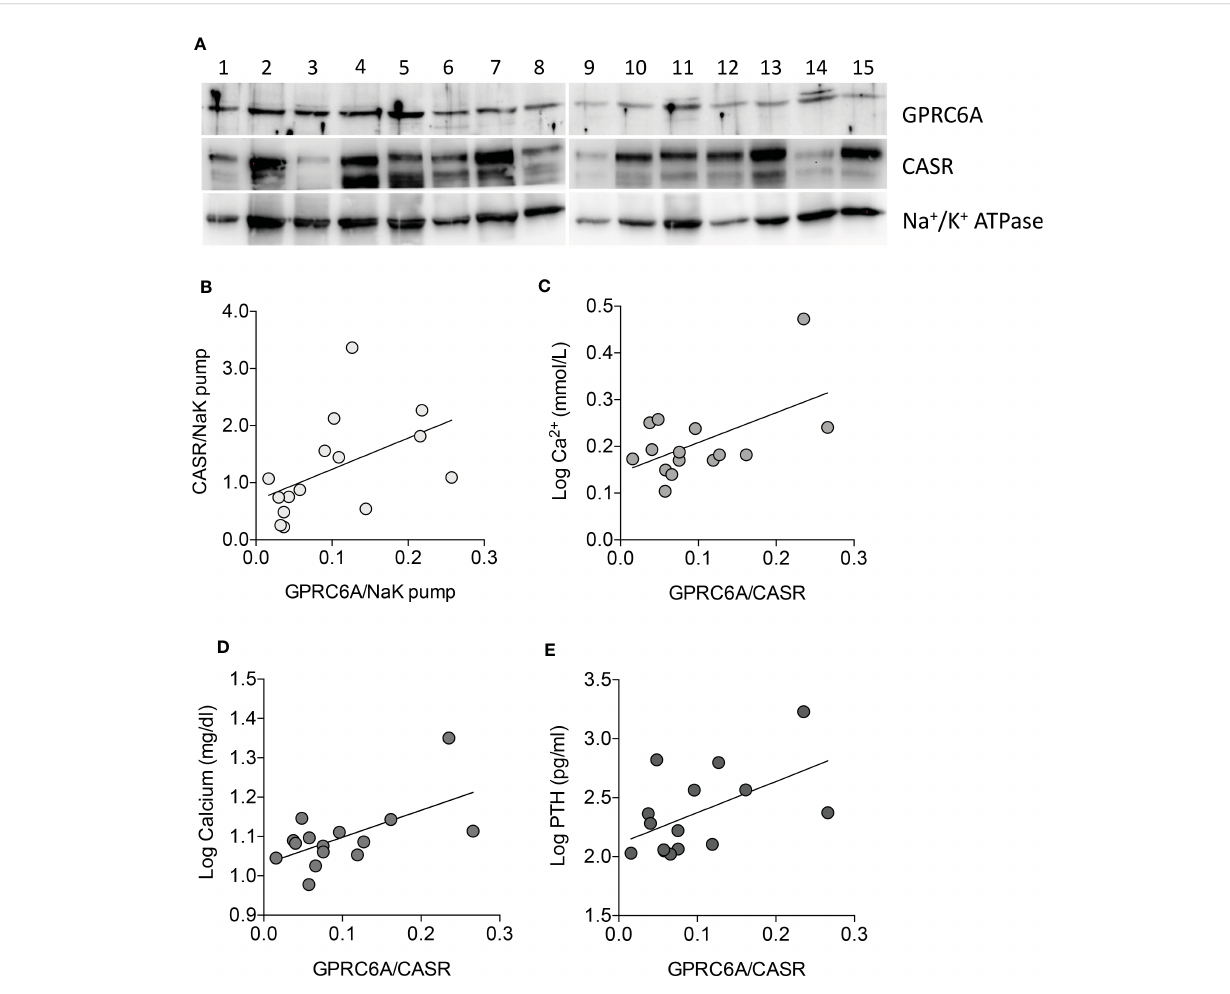
FIGURE 4 GPRC6A and CASR expression in membrane protein fractions from PAds and correlation with clinical features. (A) Western blot analysis of GPRC6A and CASR expression in membrane protein fractions from a series of PAds (n=15); GPRC6A speci fi c band was detected at 105 kDa; speci fi c CASR bands were detected at 130 and 150 kDa; Na + /K + ATPAse was used as loading control. (B) Correlation between GPRC6A and CASR membrane proteins in the PAds series (r=0.618, P=0.014 by Spearman coef fi cient of correlation). (C) Correlation between GPRC6A/CASR ratio and plasma ionized calcium levels, expressed as log2 (r=0.552, P=0.033 by Pearson coef fi cient of correlation). (D) Correlation between GPRC6A/CASR ratio and serum total calcium levels, expressed as log2 (r=0.602, P=0.018 by Pearson coef fi cient of correlation). (E) Correlation between GPRC6A/CASR ratio and plasma PTH levels, expressed as log2 (r=0.539, P=0.038 by Pearson coef fi cient of